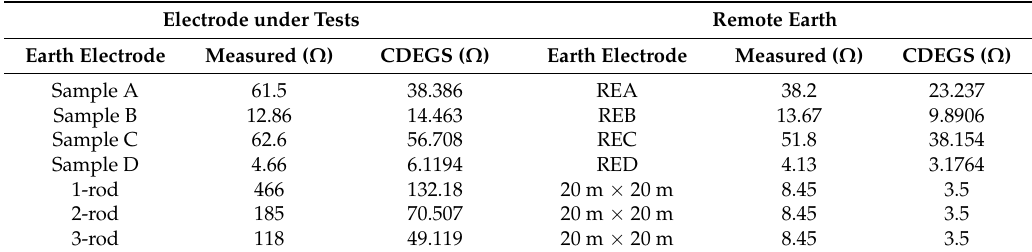
Table 2. RDC of electrode under tests and remote